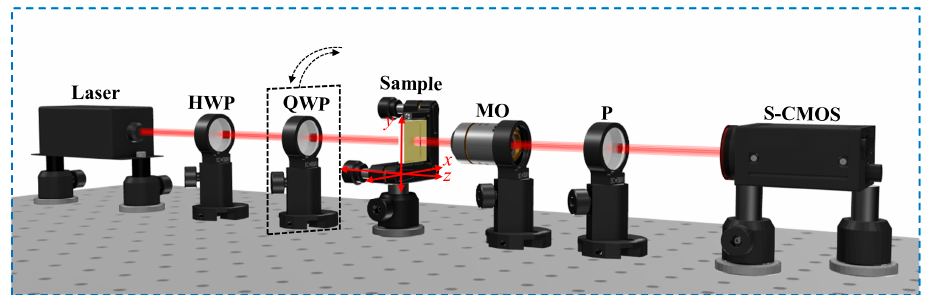
Figure 5. The diagram of experimental optical setup. From left to right, the optical devices including the laser, half-wave plate (HWP), quarter-wave plate (QWP), sample and three-dimensional trans- lation stage, microscopic objective lens (MO), analytical polarizer (P), and sCMOS camera are